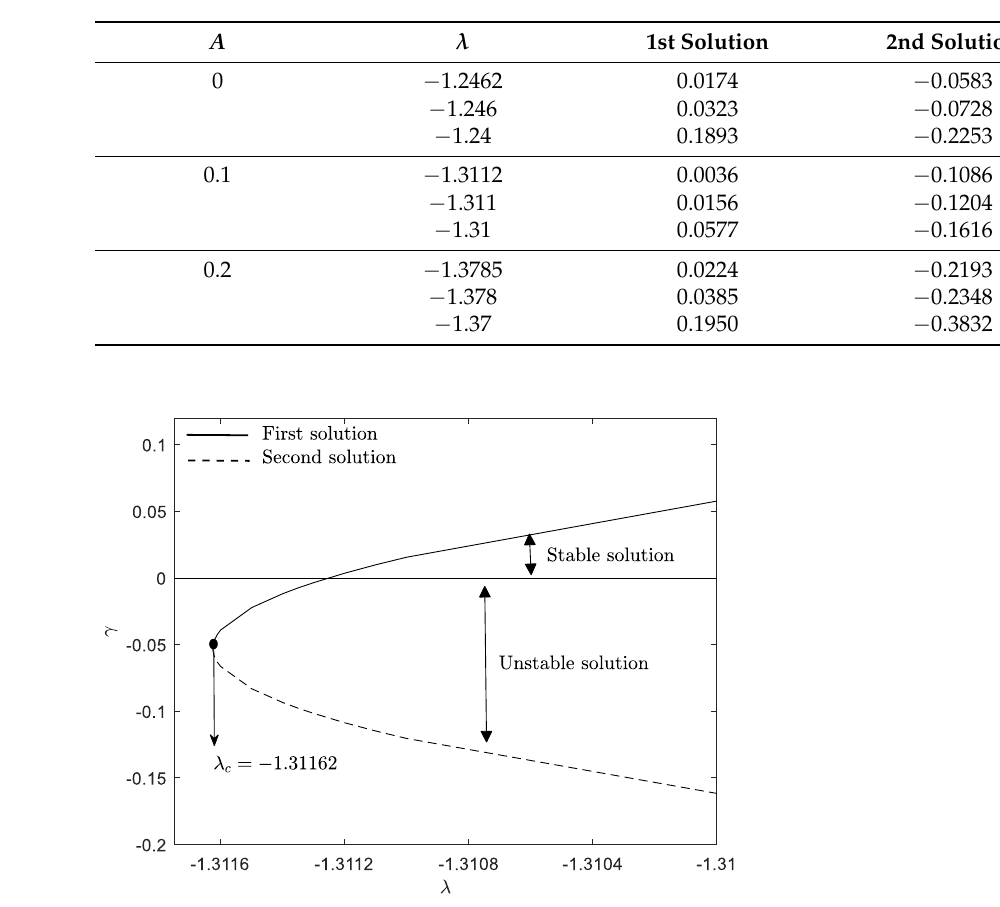
Figure 9. Smallest eigenvalues γ against λ when ϕ 1 = ϕ 2 = 0.01, A = Rd = 0.1, K = 1, n =